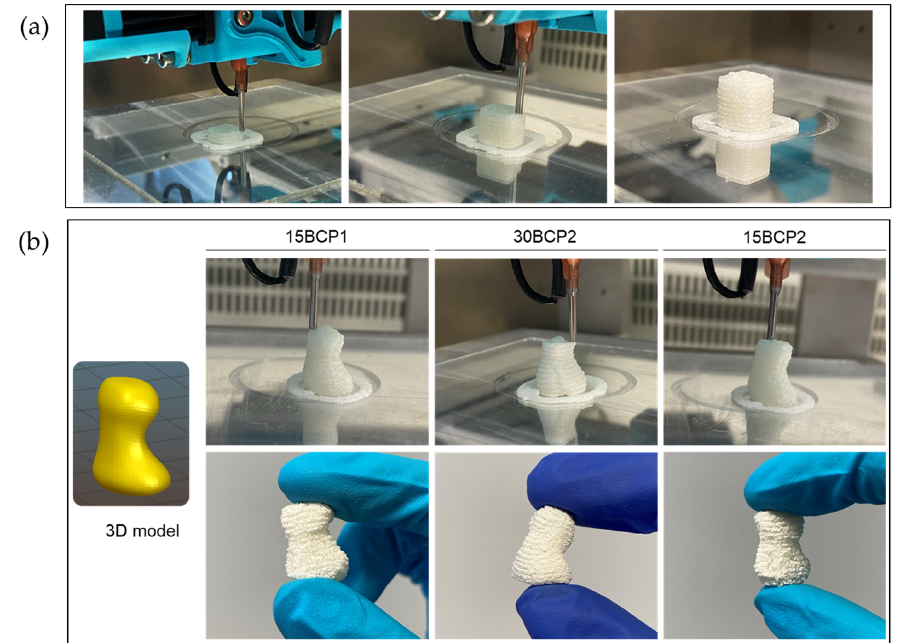
Figure 9. ( a ) Representative images of the printing process of cubes for swelling tests. ( b ) Phalanx model printed to evaluate the proper execution of rounded shapes. Dehydrated samples correctly retained their shape.